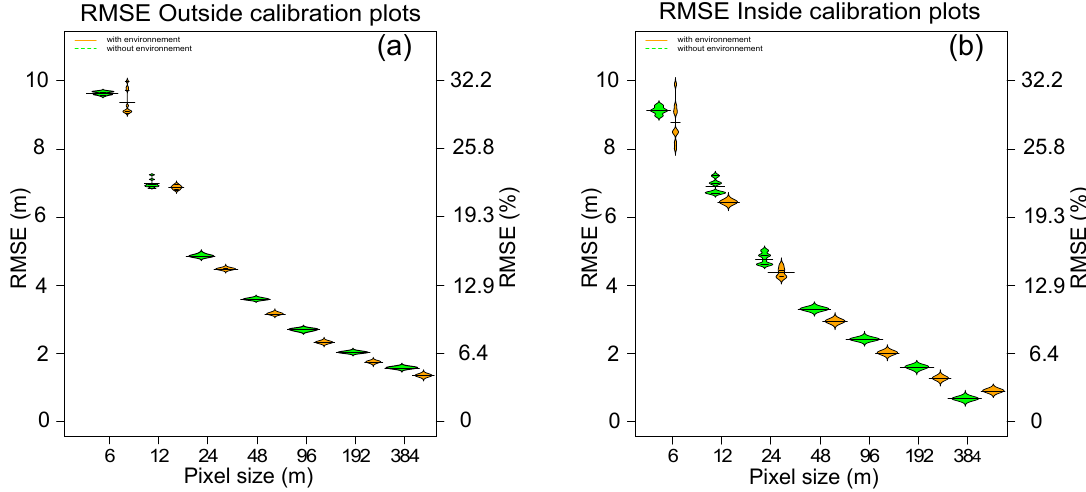
Figure 5. Violin plots showing the density of the root mean square (RMSE) for 10 height prediction maps for each pixel size. Green violin plot represents RMSE without covariables, and orange violin plot represents RMSE with covariables. ( a ) RMSE outside plots; ( b ) RMSE inside plots p1, p2,